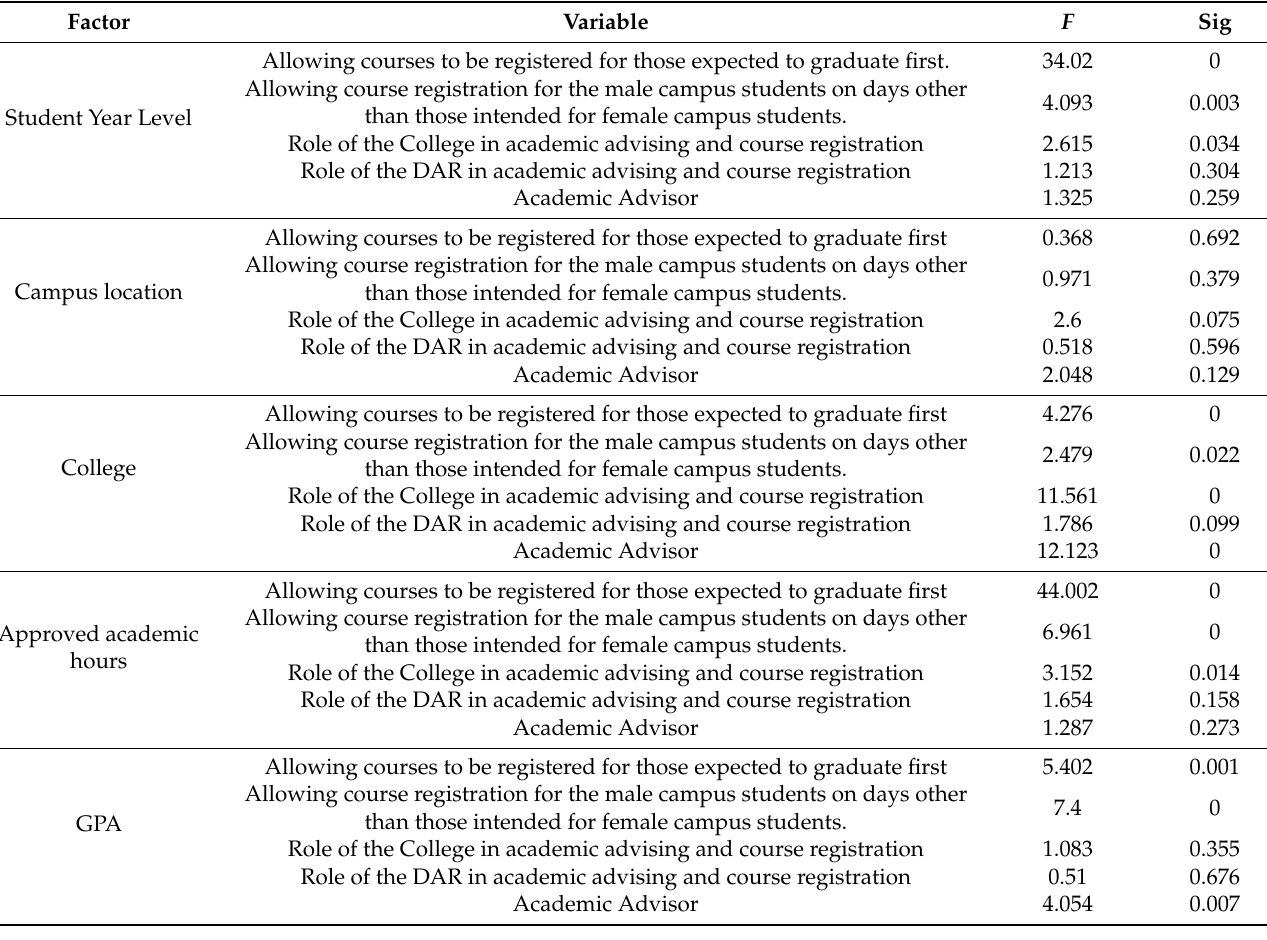
Table 23. F test results for study variables by different